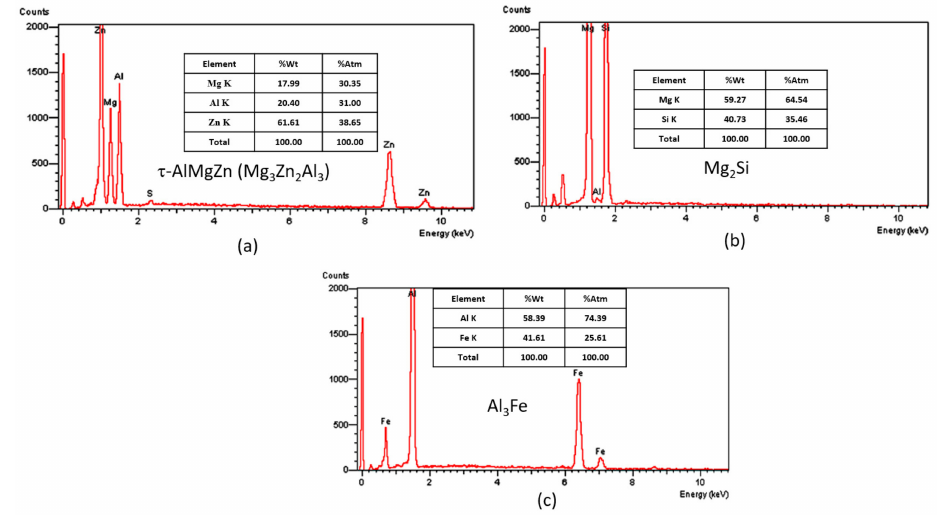
Figure 3. Microanalysis obtained. ( a ) τ -AlMgZn (Al 2 Mg 3 Zn 3 ), ( b ) Mg 2 Si, and ( c ) Al 3